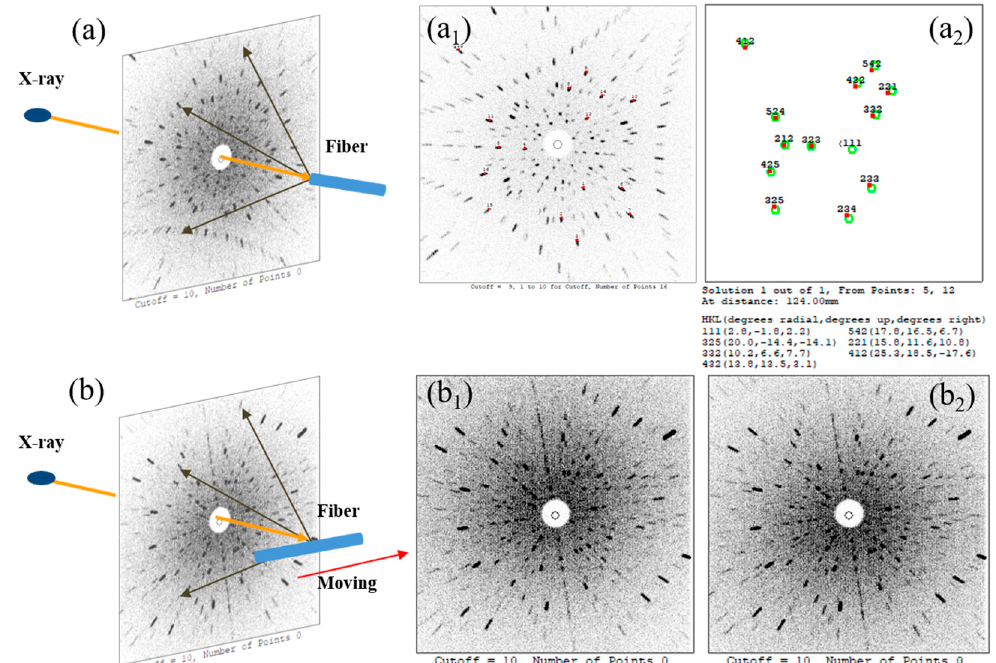
Figure 6. ( a , b ) Schematic diagrams of the Laue back-reflection measurements. ( a 1 , a 2 ) Characteristic Laue back-reflection pattern and crystal orientation of fiber end face. ( b 1 , b 2 ) Characteristic Laue back-reflection patterns at different positions with the X-ray beam hitting the SCF.